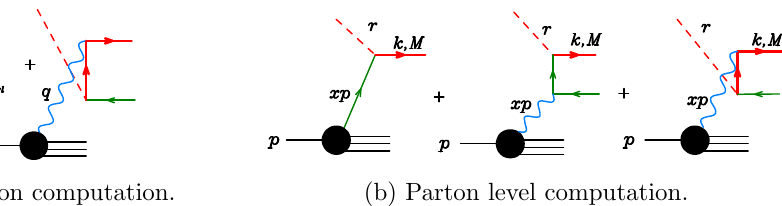
Figure 1. Our basic (cid:12)ctitious process, with a scalar of momentum r scattering o(cid:11) a light lepton and turning it into a heavy lepton of mass M , represented by the thick red fermion line. In (a) we show the sum of the two diagrams that relate this process to the ep scattering structure functions. In (b) we show the diagrams that enter the calculation of the same process at next-to-leading order according to the QCD factorization formula. Notice that the second and third diagram in (b) (unlike the (a) diagrams) are computed for an on-shell photon, and the collinear singularity from the photon splitting into leptons that arises there is